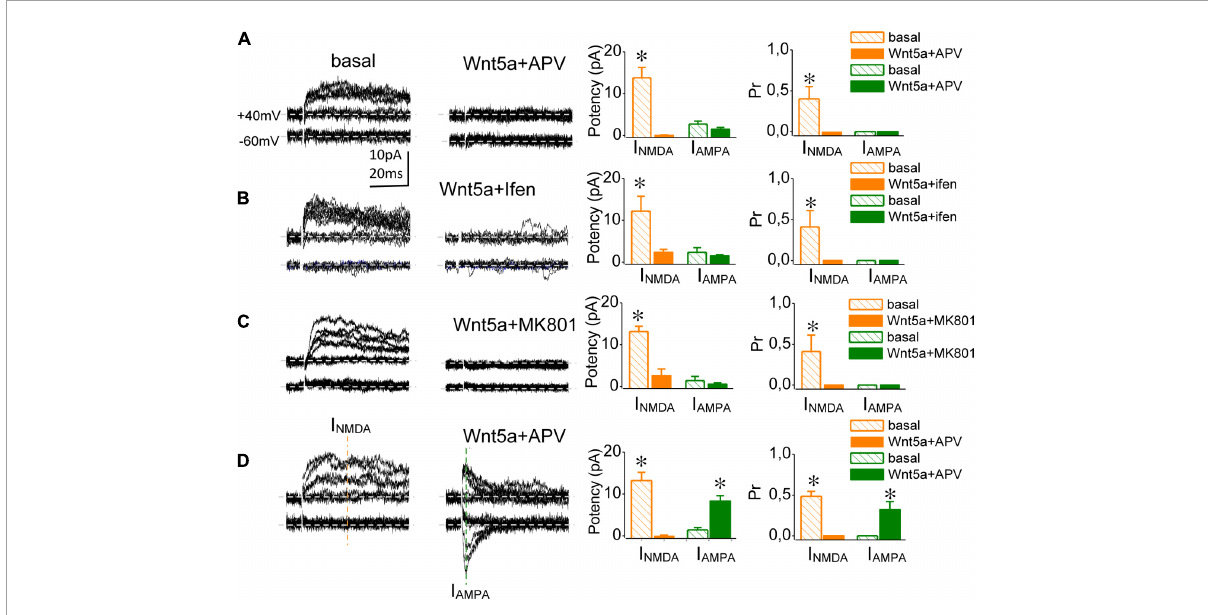
FIGURE3 Wnt-5a-induced conversion occurs by both NMDAR-dependent and NMDAR-independent mechanisms. (A) meEPSC traces from representative NMDA-independent silent synapses (converted group) recorded at baseline and (right) 60 min after Wnt-5a perfusion in the presence of APV (20 µ M, left ). Average change in the synaptic potency and Pr from I NMDA (orange) and I AMPA (green) meEPSC components obtained at baseline and after 60 min of Wnt-5a plus APV ( lower graphics , respectively). (B) meEPSC traces from representative NMDA-dependent silent synapses (unconverted group) recorded at baseline (right) and 60 min after Wnt-5a perfusion plus APV (left) . Average change in the synaptic potency and Pr of I NMDA (orange) and I AMPA obtained at baseline and after 60 min of Wnt-5a plus APV ( lower graphics , respectively). (C) Superimposed meEPSC traces recorded at baseline (right) and 60 min after Wnt-5a perfusion in the presence of ifenprodil (10 µ M; left ). The average change in the synaptic potency and Pr at baseline and after 60 min of Wnt-5a plus ifenprodil, recorded at –60 and + 40 mV ( lower graphics , respectively). (D) Superimposed meEPSC traces were recorded at baseline (right) and 60 min after perfusion with MK-801 (40 µ M) plus Wnt-5a (left) . Average change in the synaptic potency and Pr at baseline and after 60 min of Wnt-5a plus MK-801, recorded at –60 and + 40 mV ( lower graphics , respectively). Statistics: Error bars indicate ± SEM, t -test (* p <